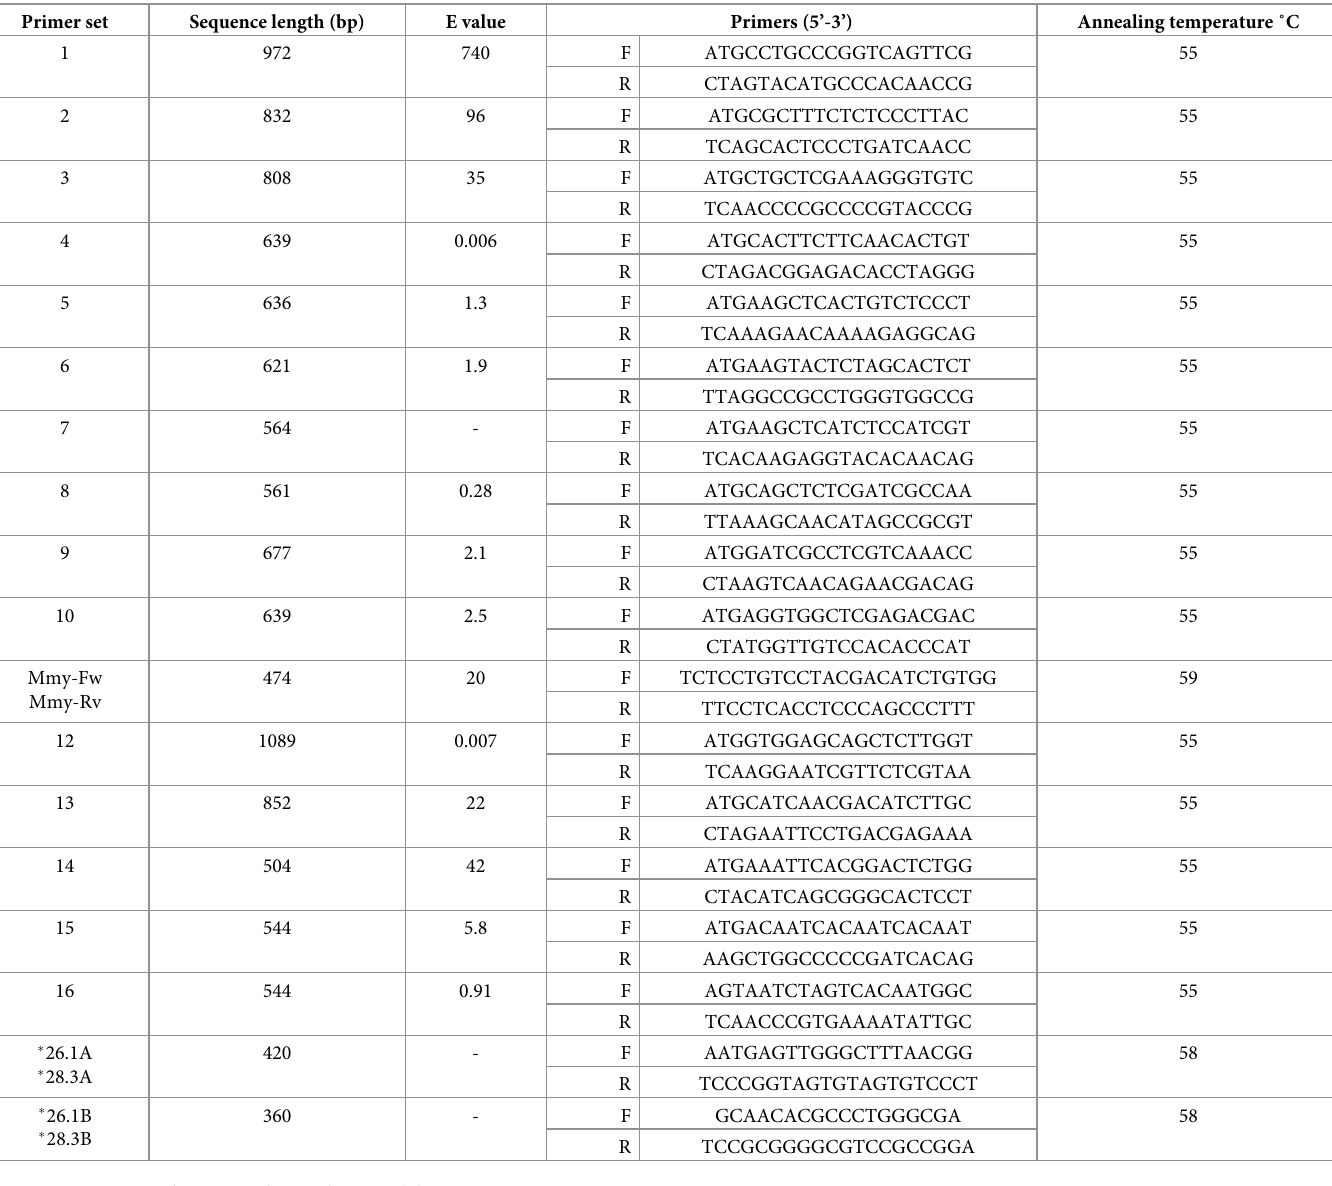
Table 1. The sixteen predicted protein sequences with their corresponding size, primer sequences and annealing temperatures. Primer